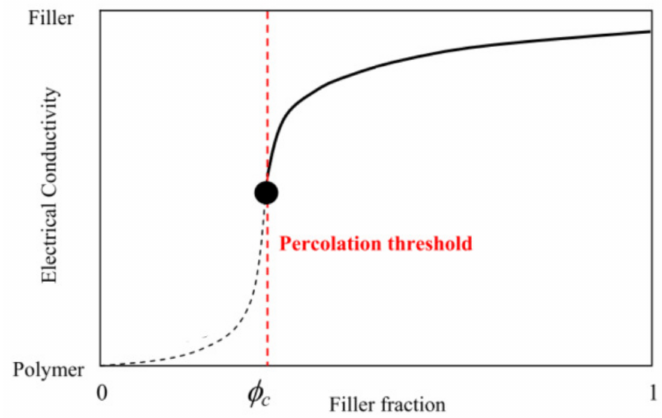
Figure 1. Electrical conductivity as a function of filler fraction.